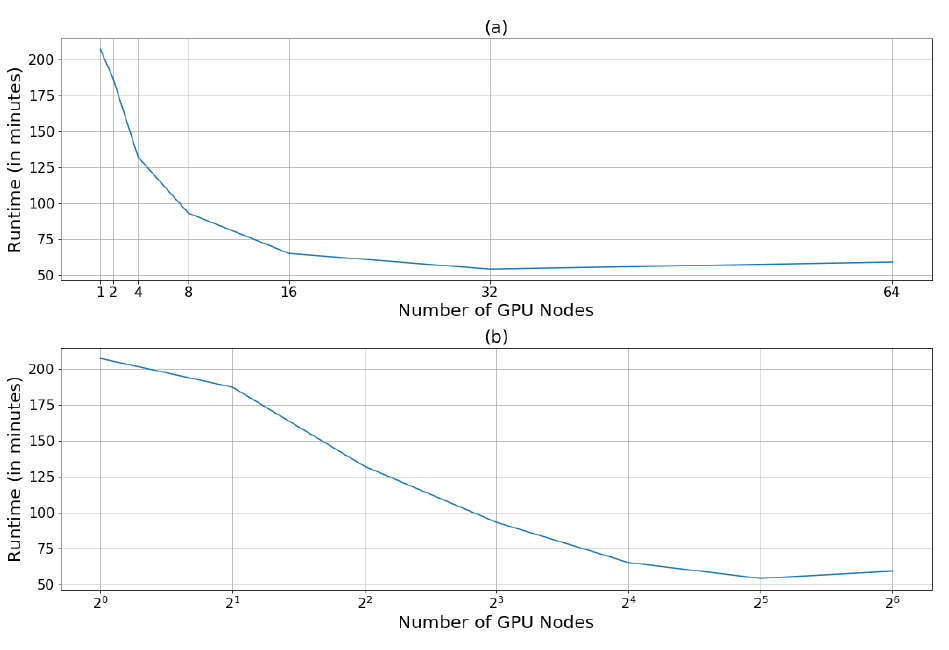
Figure 6. Training duration (in minutes) as more GPU nodes are recruited, ( a ) on a linear scale and ( b ) on a logarithmic